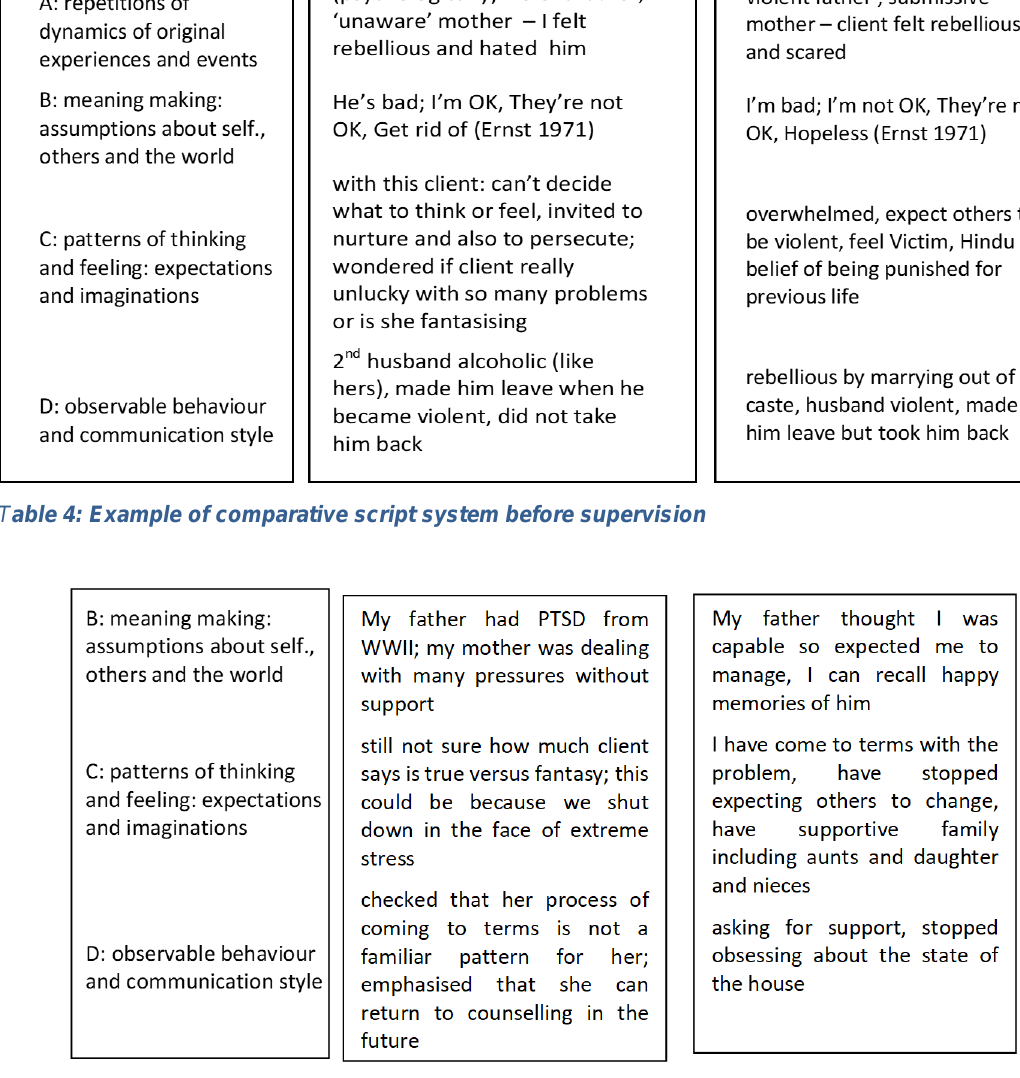
Table 5: Example of comparative script system after